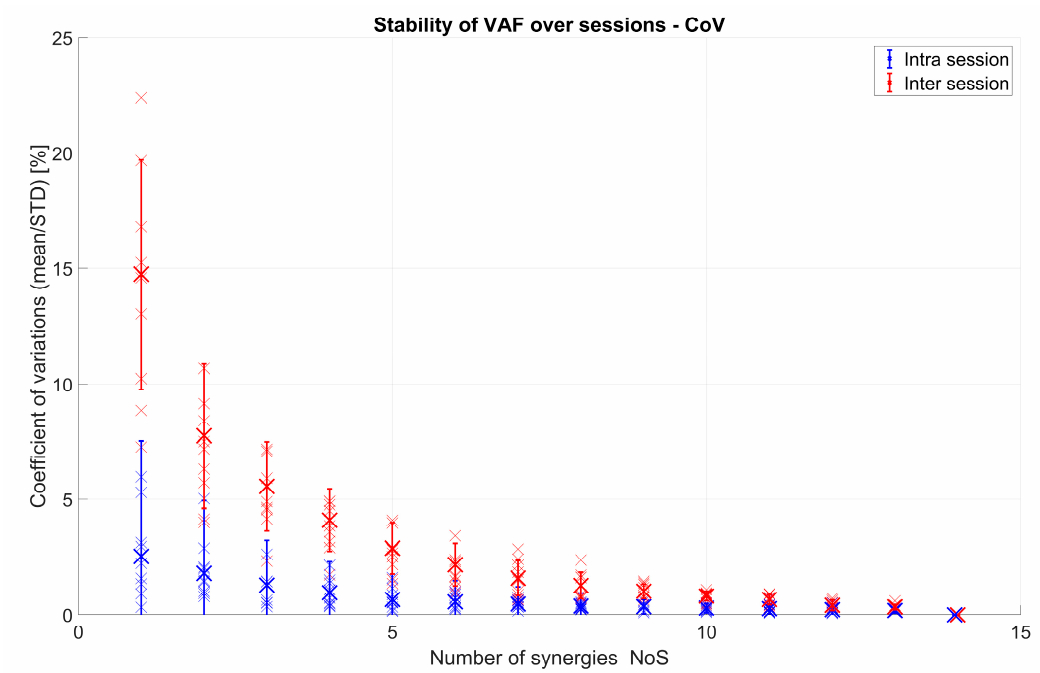
Figure 11. Intra-session (blue) and inter-session (red) coe ffi cient of variation (CoV) of VAF values for 10 subjects: Inter-session was achieved by comparing VAF values between 5 sessions of each person, whereas intra-session was achieved by comparing VAF values for 5 movement sub-selections inside the same session (and repeated and averaged for all sessions). Each small “x” represents one person, and the bigger “X” represents the mean of all 10